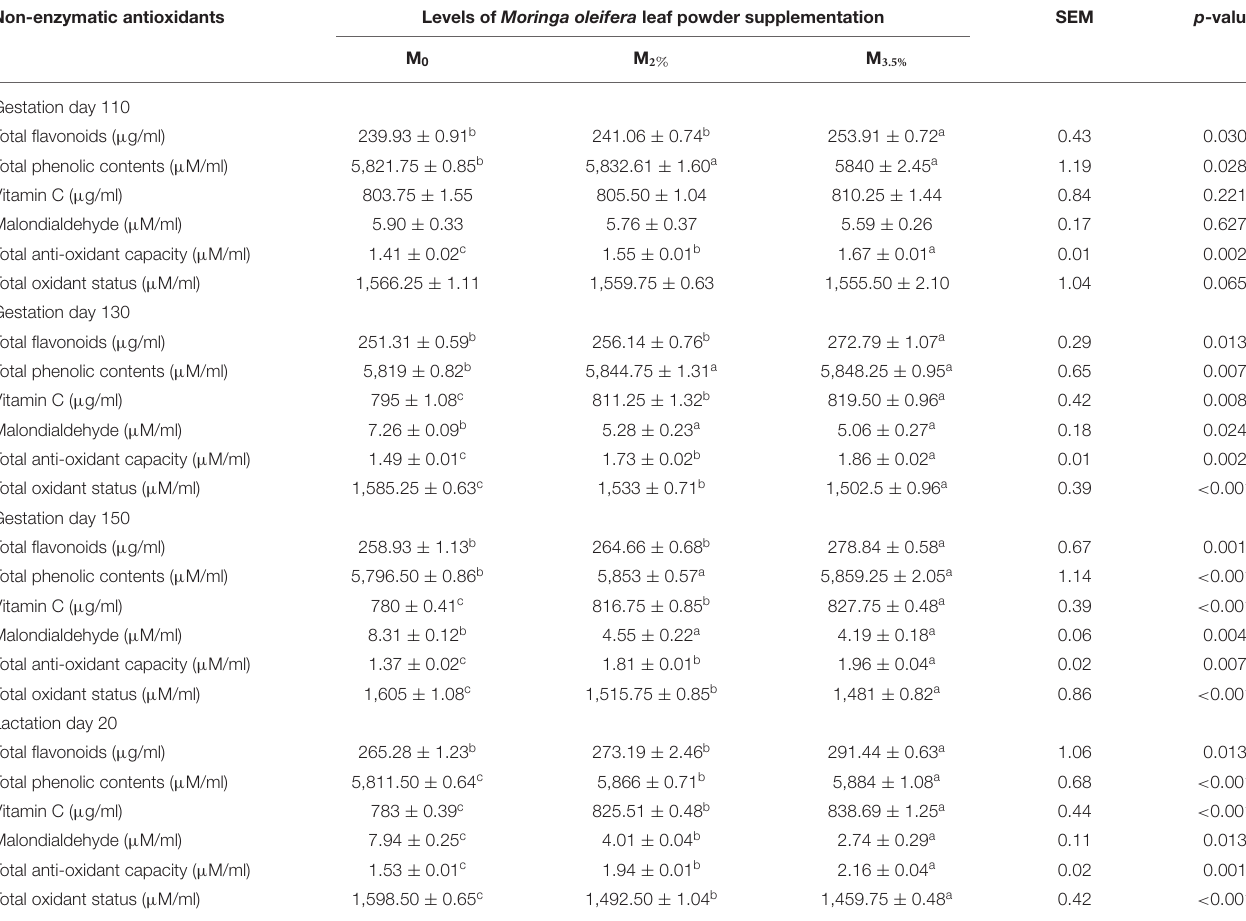
TABLE 4 | Plasma non-enzymatic antioxidant indices of Beetal goats. Non-enzymatic